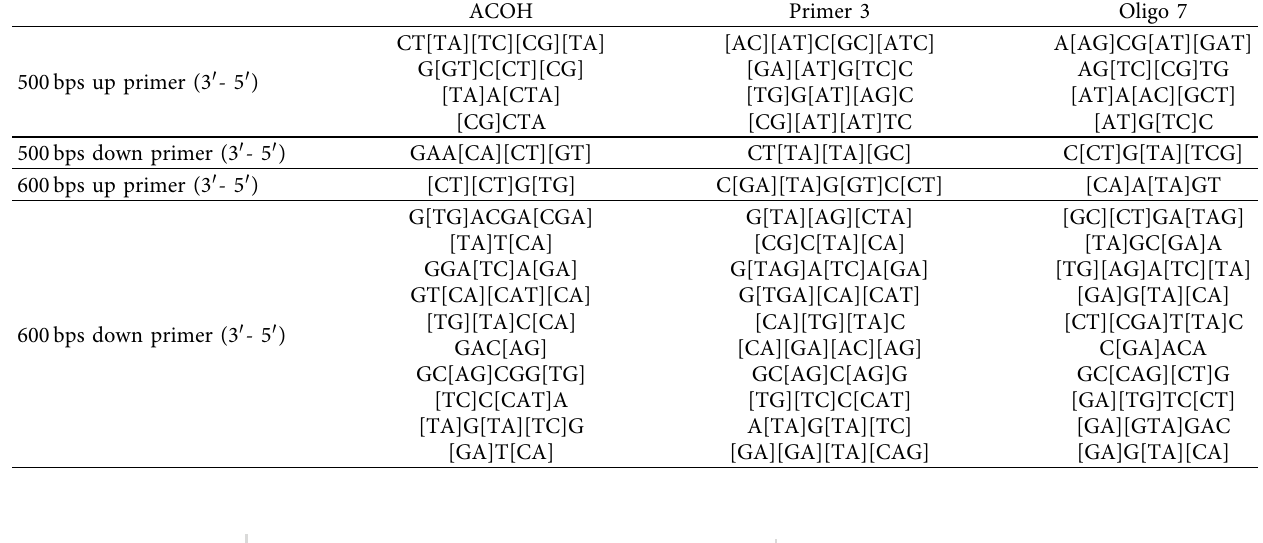
Table 2: DNA sequence analysis at 500bps and 600bps under three conditions.